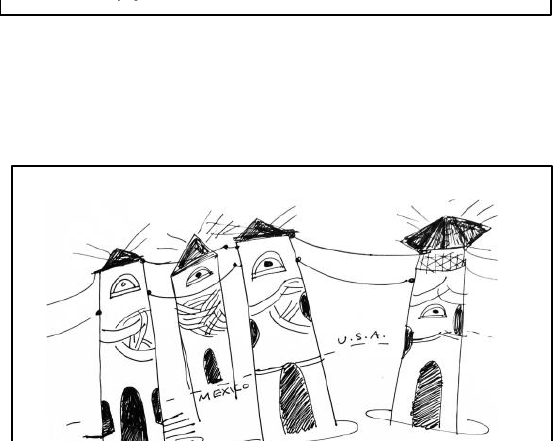
Figure 7 J. M. Design Studio, “Prototype #5 A Wall of Lighthouses for the Border” from The Other Border Wall Proposals (2017). Digital scanned image of ink drawing on paper, text. 8 ½ X 11 inches. Collection of J. M. Design